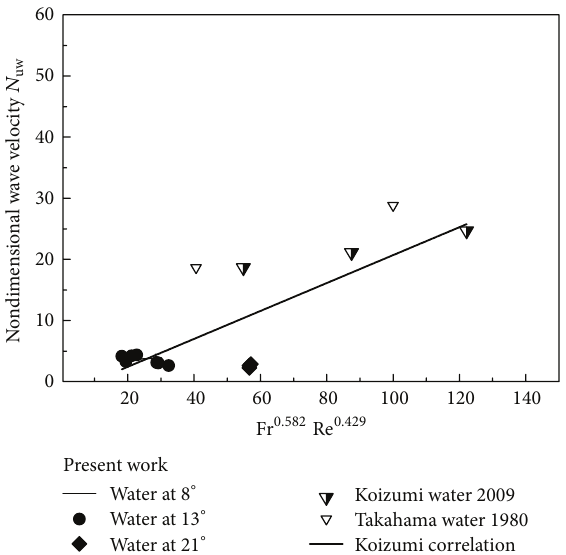
Figure 9: Comparison of nondimensional propagation velocity between experiments and Koizumi correlation.